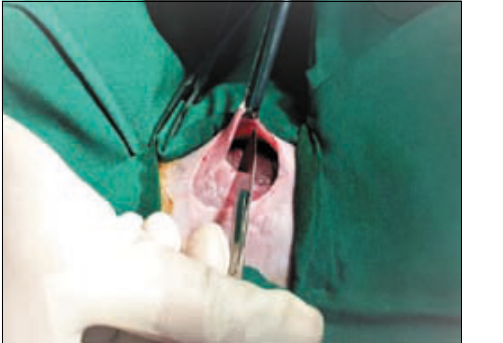
Fig. 5 . Application of Olive-oil Vitamin